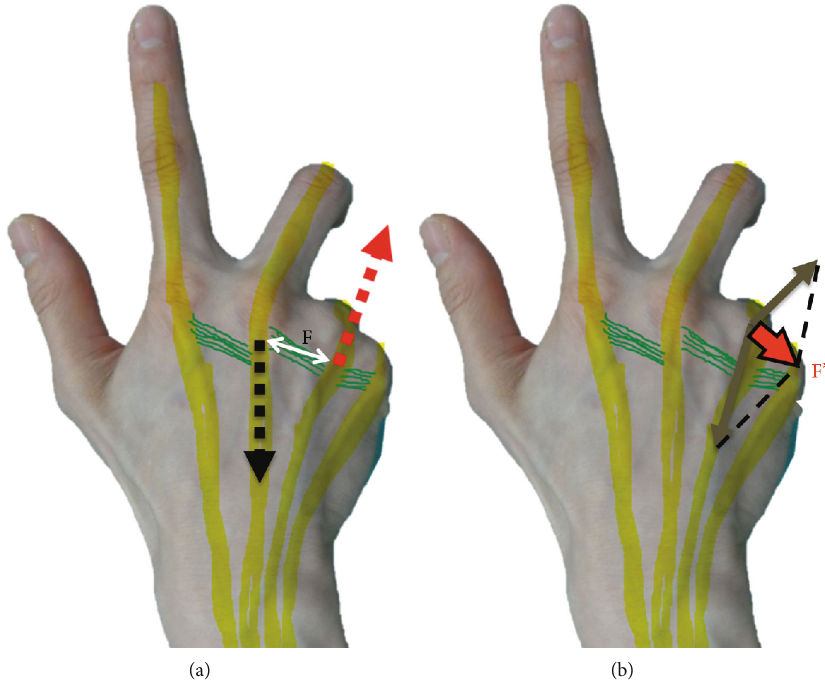
Figure 3: Schematic images of an ulnarward translation force to the extensor tendon of the ring fi nger. (a) Force to the sagittal band between the middle and ring fi ngers. In the middle fi nger, when the metacarpophalangeal joint (MCPj) was extended, the extensor tendon was retracted proximally (black arrow). However, in the ring fi nger, when the MCPj was fl exed, the extensor tendon was retracted distally (red arrow). The traction force to the sagittal band and the juncturae tendinum between the middle and ring fi ngers (F) may become larger and result in sagittal band and juncturae tendinum attenuation. (b) Force-vector combination to the extensor tendon at the MCPj of the ring fi nger resulting from MCPj fl exion and ulnar deviation may develop an ulnarward translation force (F ′ ).